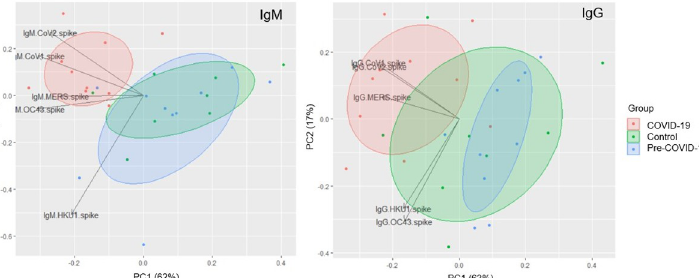
Fig 2. PCA plot of IgM and IgG pan-CoV responses. PCA plot showing IgM (left) and IgG (right) responses to spike proteins for SARS-CoV-2, SARS-CoV-1, MERS-CoV, OC43, and HKU1 for COVID-19 (red), Control (green), and pre-COVID (blue) samples. Each data point reflects a single sample colored by group; loading vectors reflecting the direction of the contribution of each parameter to the PCA plot is shown. Ellipses denote the 50% confidence interval for each